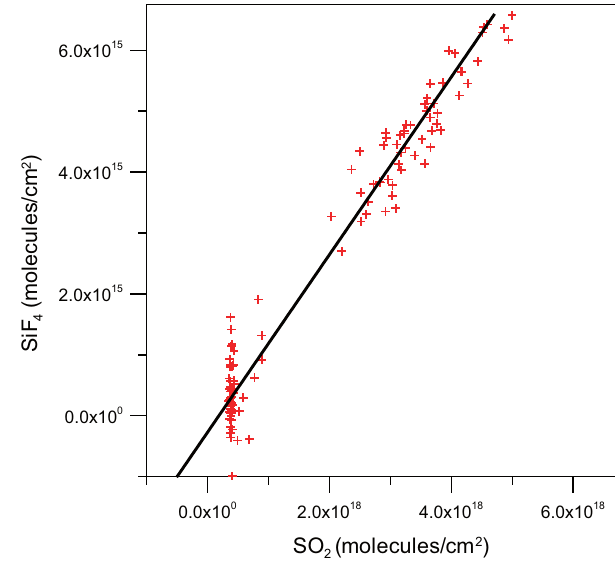
Fig. 15. SiF 4 /SO 2 correlation plot from data in Fig. 10 including both plume and clear-sky spectra ( slope=(1.4 ± 0.07) × 10 − 3 .)